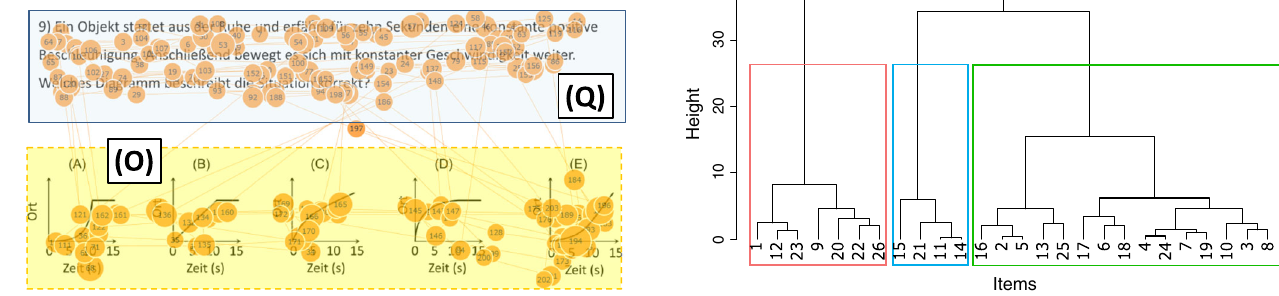
FIG. 1. Definition of AOIs. The Q-AOI covers the question and the O-AOI covers all answer choices. The AOIs that cover single options are not shown for the sake of clarity.